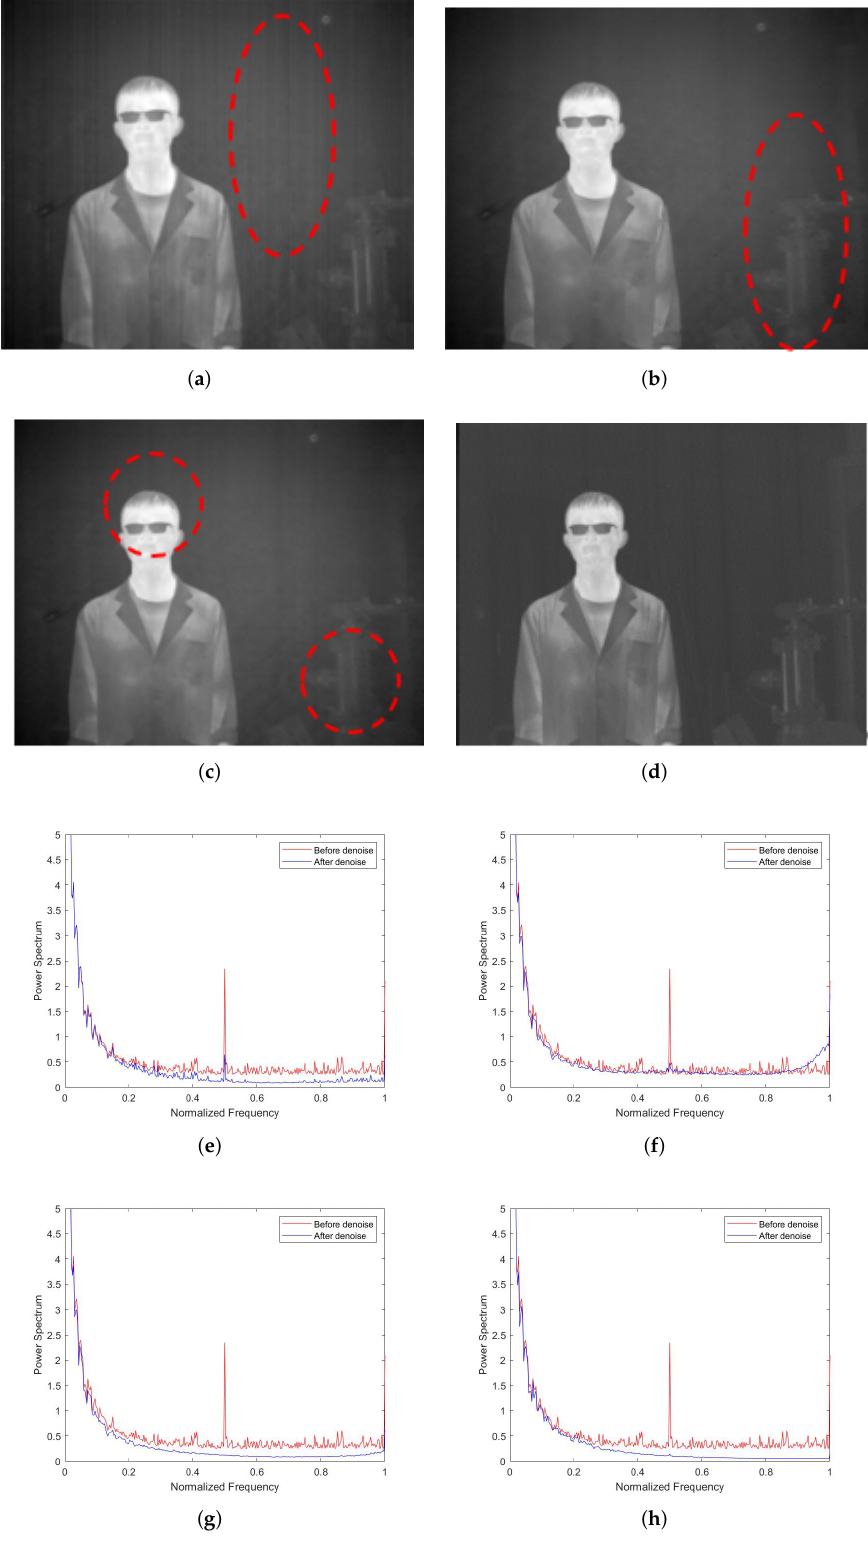
Figure 11. Denoising effects of different methods on an image of a person : (a) MSGF; (b) WAGE; (c) TVGF; (d) our approach; (e) MSGF; (f) WAGE; (g) TVGF; (h) our approach.